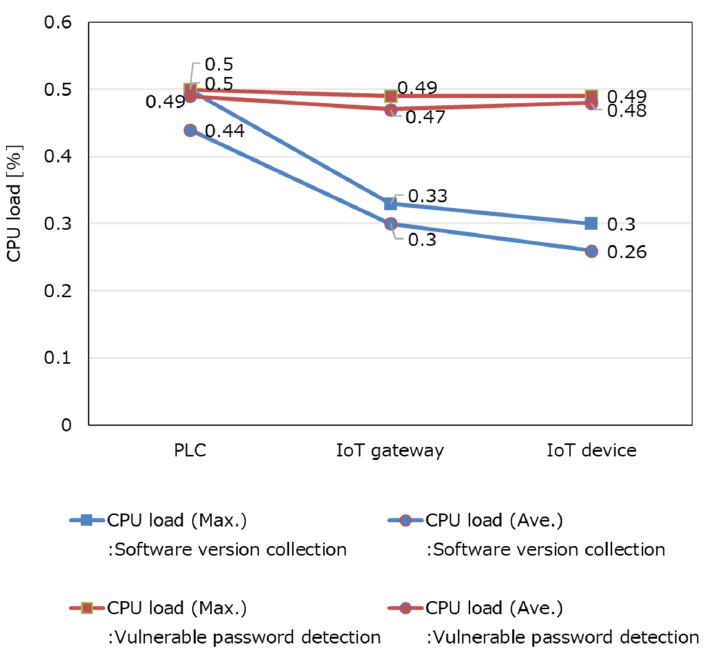
Figure 7. Performance test (CPU load).